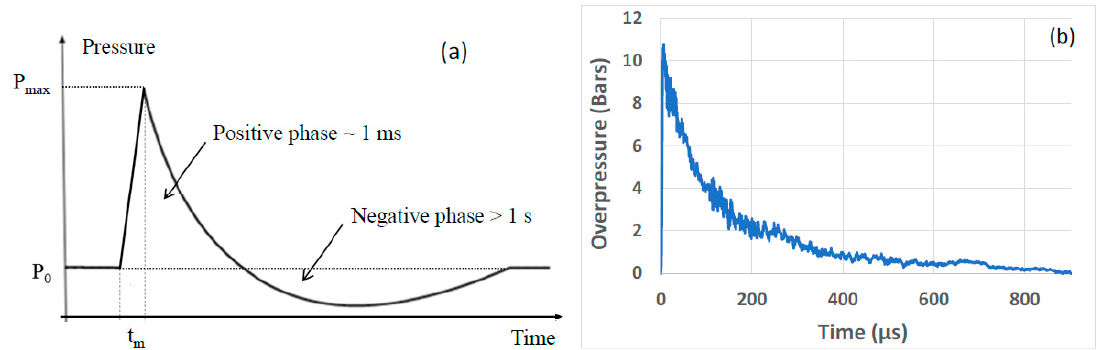
Figure 1. Typical dynamic pressure variation during an air blast experiment: ( a ) Illustration of the different phases and ( b ) example of pressure measurement at 1m from 1kgTNT by using a Tourmaline piezoelectric